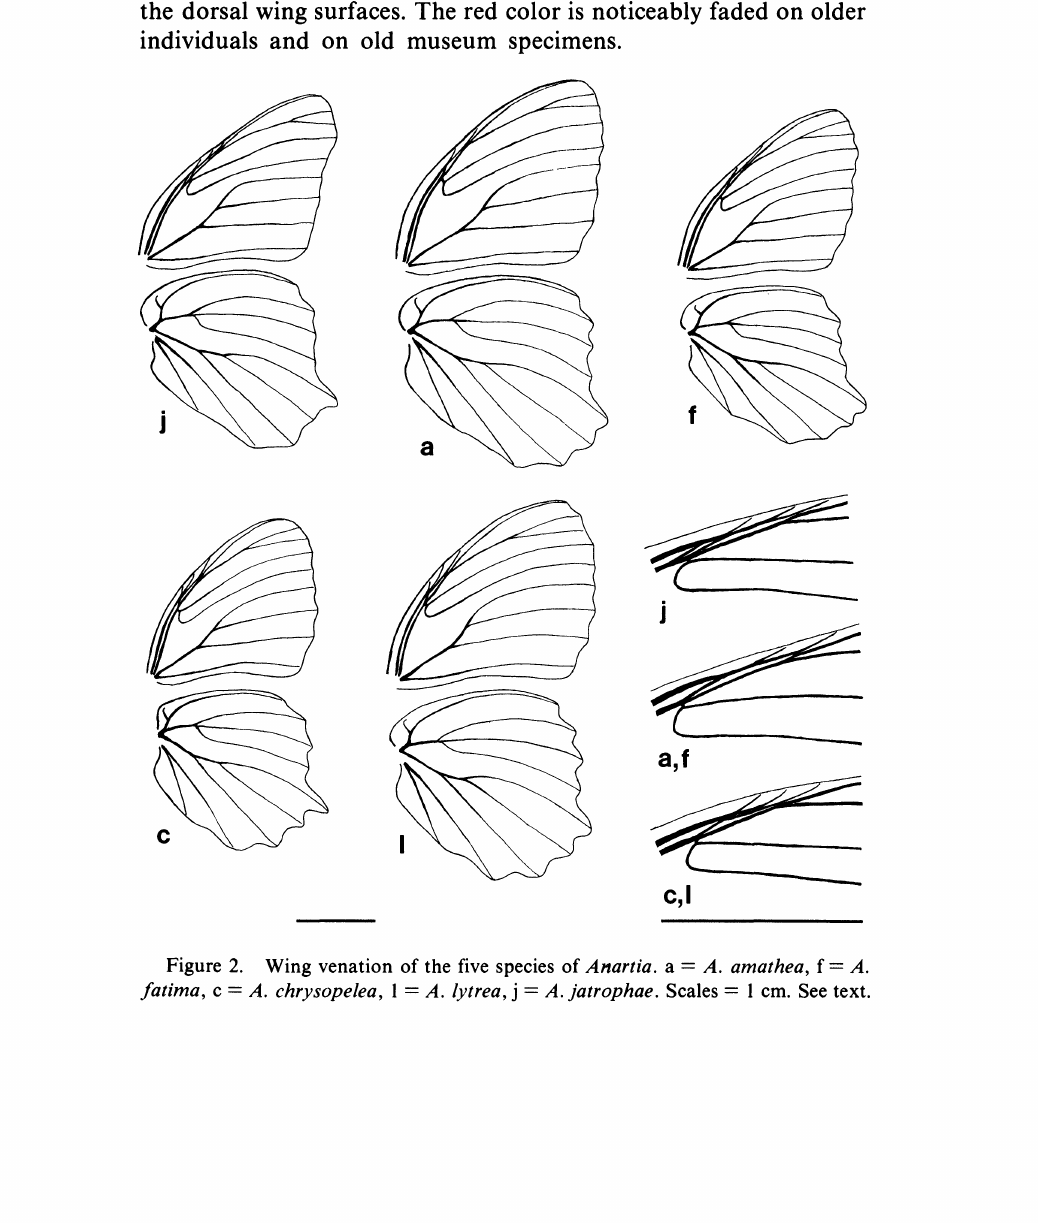
Figure 2. Wing venation of the five species of Anartia.